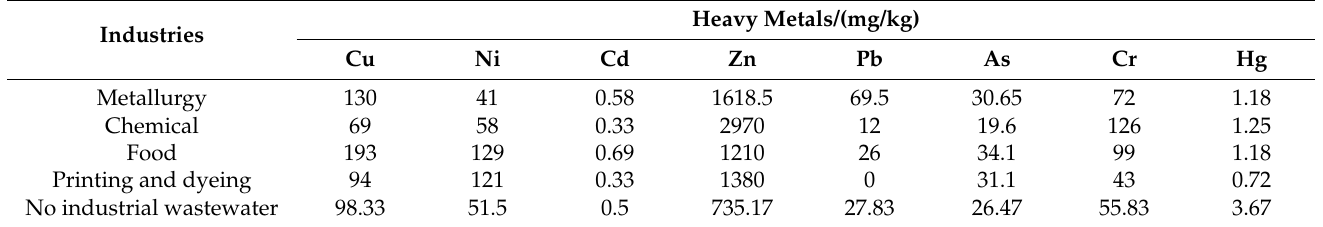
Table 4. Variation in sludge composition containing industrial wastewater from different